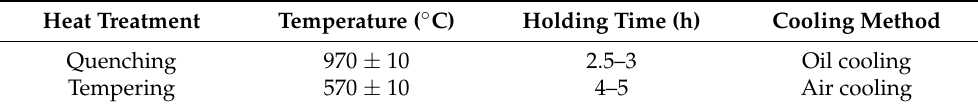
Table 3. Heat treatment process of